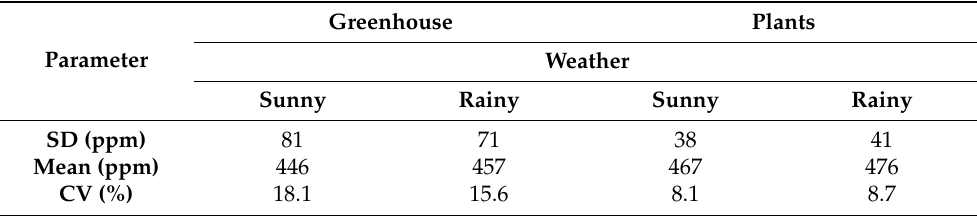
Table 6. Coefficient of variations of CO 2 concentration in the case of sunny and rainy day.